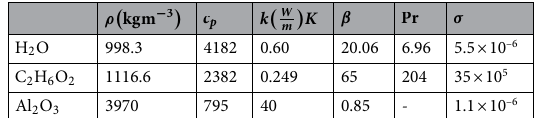
Table 2. Thermophysical properties of ethylene, water and Alumina.